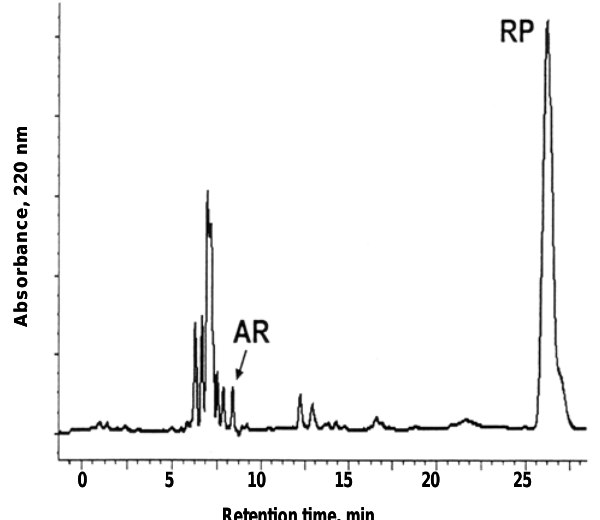
Figure 4: HPLC profile of photodecomposition of RP under sun simulated light (10mJ.CIE/cm 2